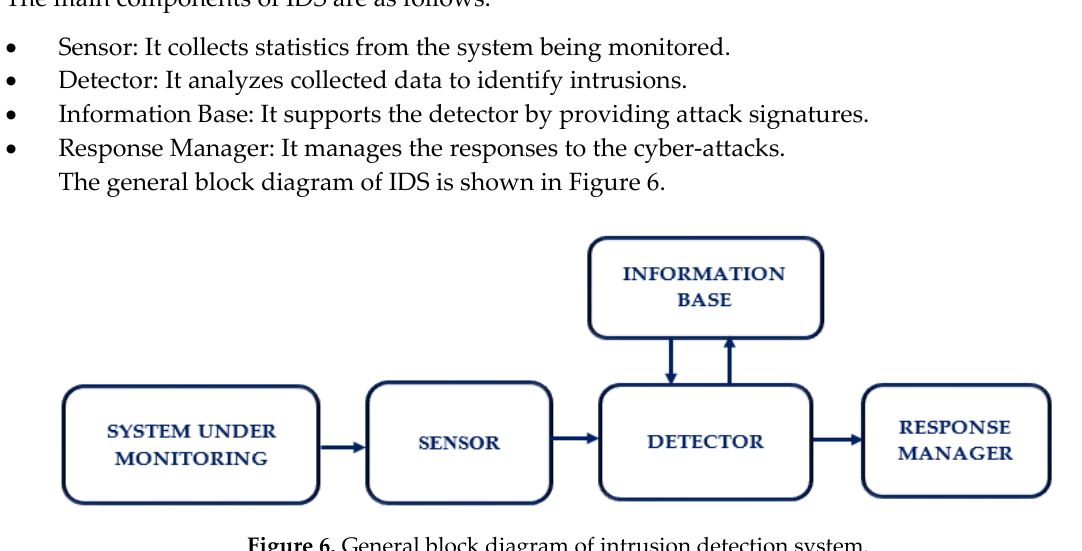
Figure 6. General block diagram of intrusion detection